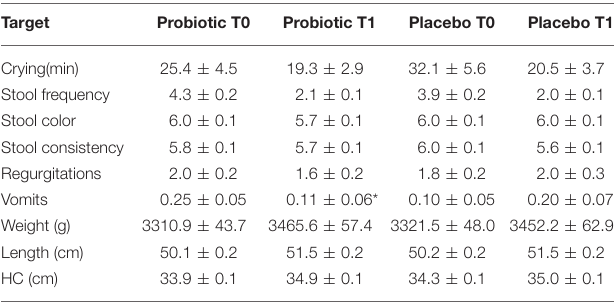
TABLE 5 | Clinical and anthropometric variations in the breast-fed group obtained with multivariable analysis of repeated measure.